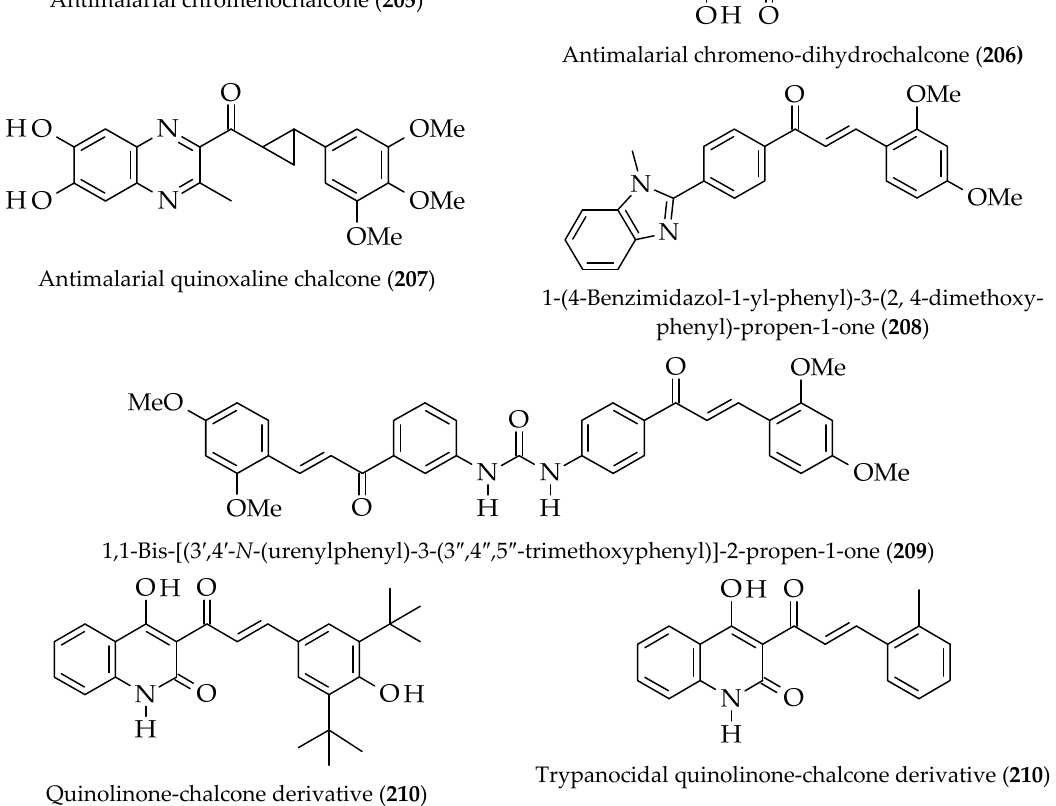
Figure 18. Structures of some synthetic antiparasitic chalcones.